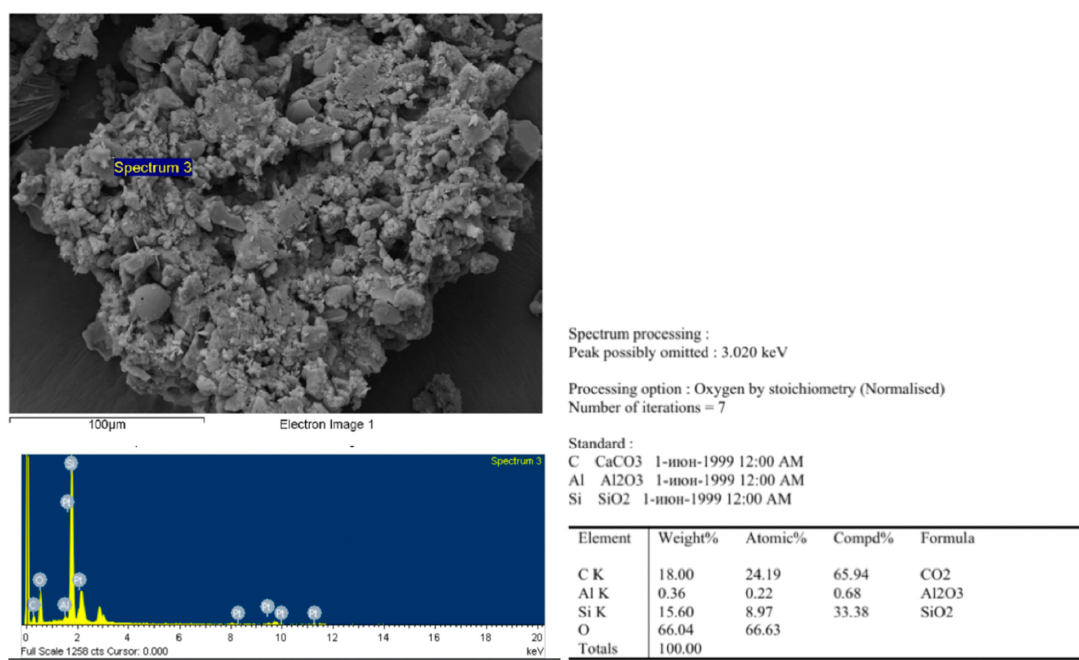
Figure 7. Morphological structure of a loose aggregate including mineral microparticles and EMF of one of the grains. SAM LEO 1450 VP, Carl Zeiss.